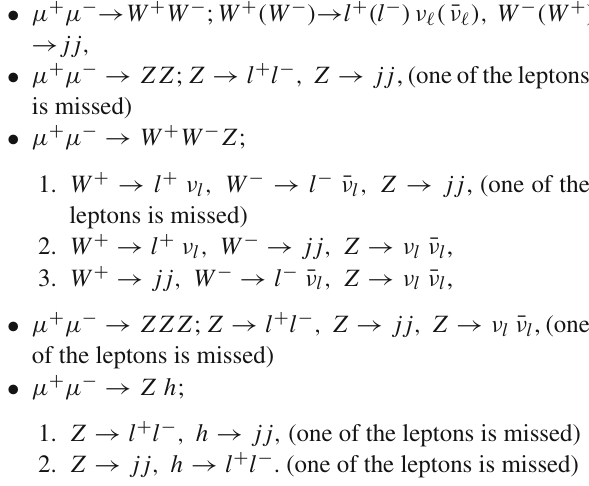
Fig.7b. Most of the transverse momentum being carried away by the leading jet, the corresponding distribution for the background peaks around zero transverse of p T j 2 for BP1,BP3 peak momentum. The distributions of p T j 2 at higher values due to the aforementioned reason. Thus > 400 GeV is chosen which significantly a cut: p T j 2 improve the signal